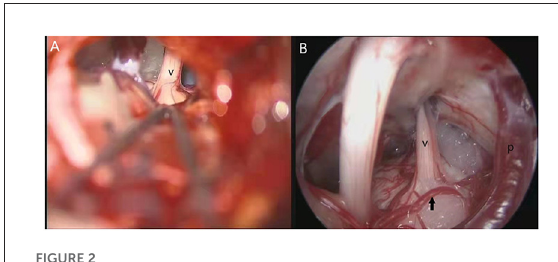
FIGURE2 Two pictures from the same operation. (A) Visual field of microscope; (B) Visual field under endoscope; v, trigeminal nerve; p, petrosal vein; arrow, a responsible artery not found under the microscope.